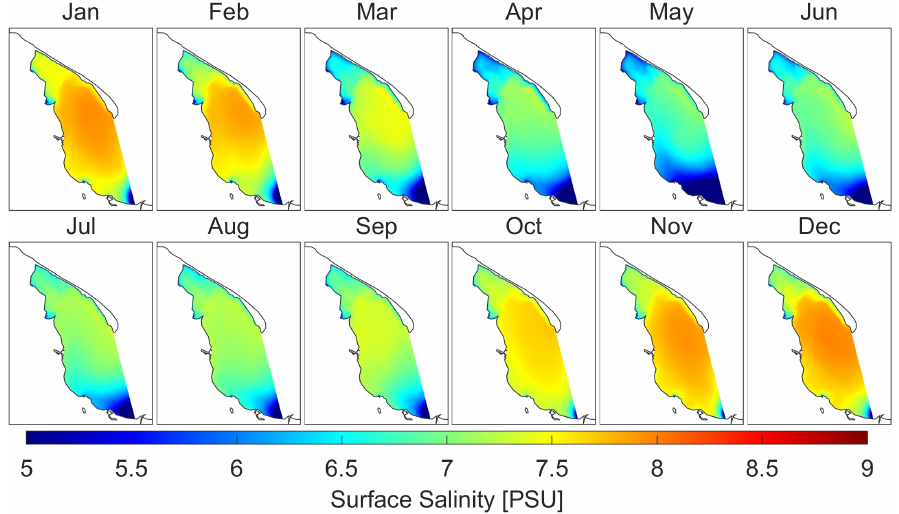
Figure 10. Monthly means of salinity at sea surface